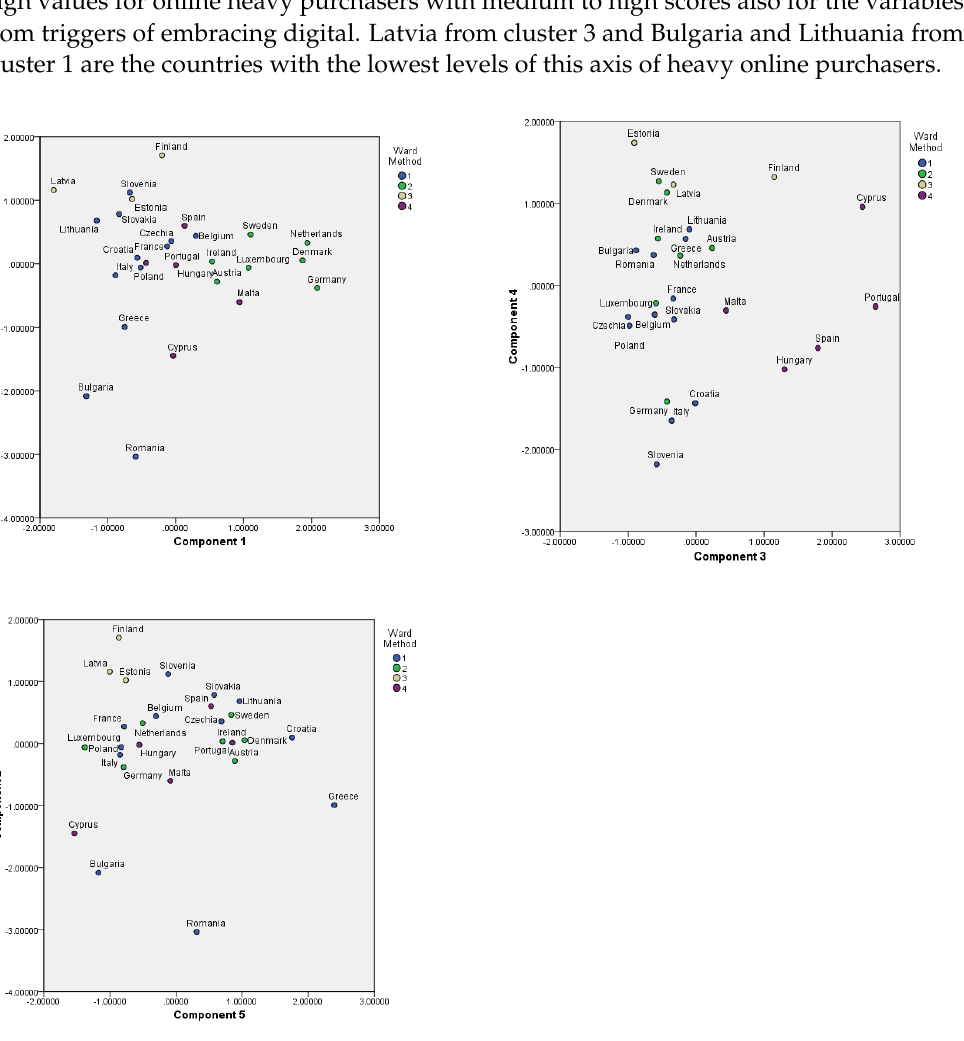
Figure 5. Projection of countries on the first five principal components. Source data: own representa- tion based on Eurostat databases 2020.